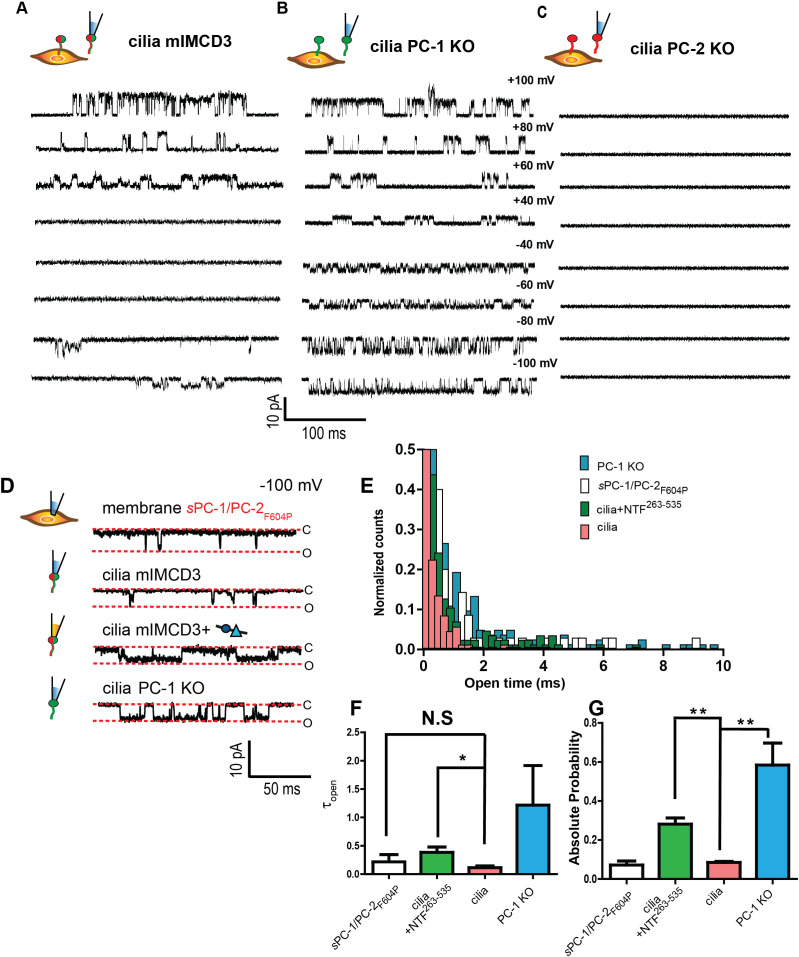
An N-terminal PC-1 fragment activates ciliary polycystin complexes.(A, B, C) Excised ciliary inside-out patch clamp recordings of channels from mIMCD-3 cells (left), PC-1 knockout mIMCD-3 cells (middle), and PC-2 knockout mIMCD-3 cells (right). (D) Single channel patch clamp recordings at −100 mV in cell attached configuration for sPC-1/PC-2F604P (top) and excised inside-out ciliary patches for mIMCD-3, mIMCD-3 with addition of NTF263-535 in pipette solution, and PC-1 knockout cells (rows 2–4, respectively). (E) Open time histogram of channel openings at −100 mV holding potential. (F) Time constants of open time distributions in E obtained using one decay equation, *p<0.05 (n = 7/38 for mIMCD-3 cilia, n = 4/13 for PC-1 KO, n = 4/23 for mIMCD-3 cilia + NTF263-535, and n = 6 for sPC-1/PC-2F604P). (G) Absolute open probabilities for recordings shown in A, B, and C, **p<0.01.